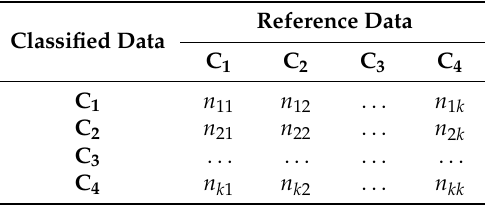
Table 1. Structure of a confusion matrix with k